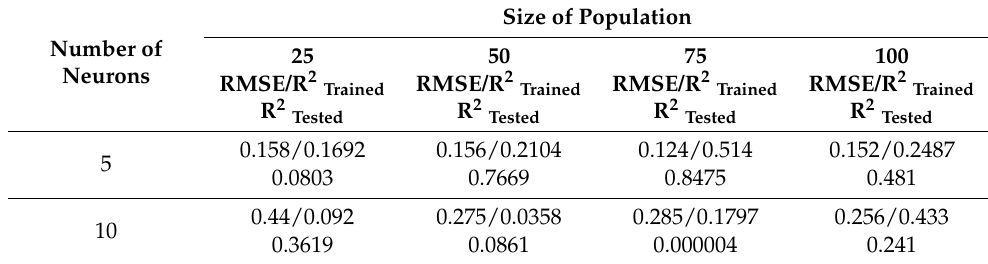
Table 6. ANN-GA training results.